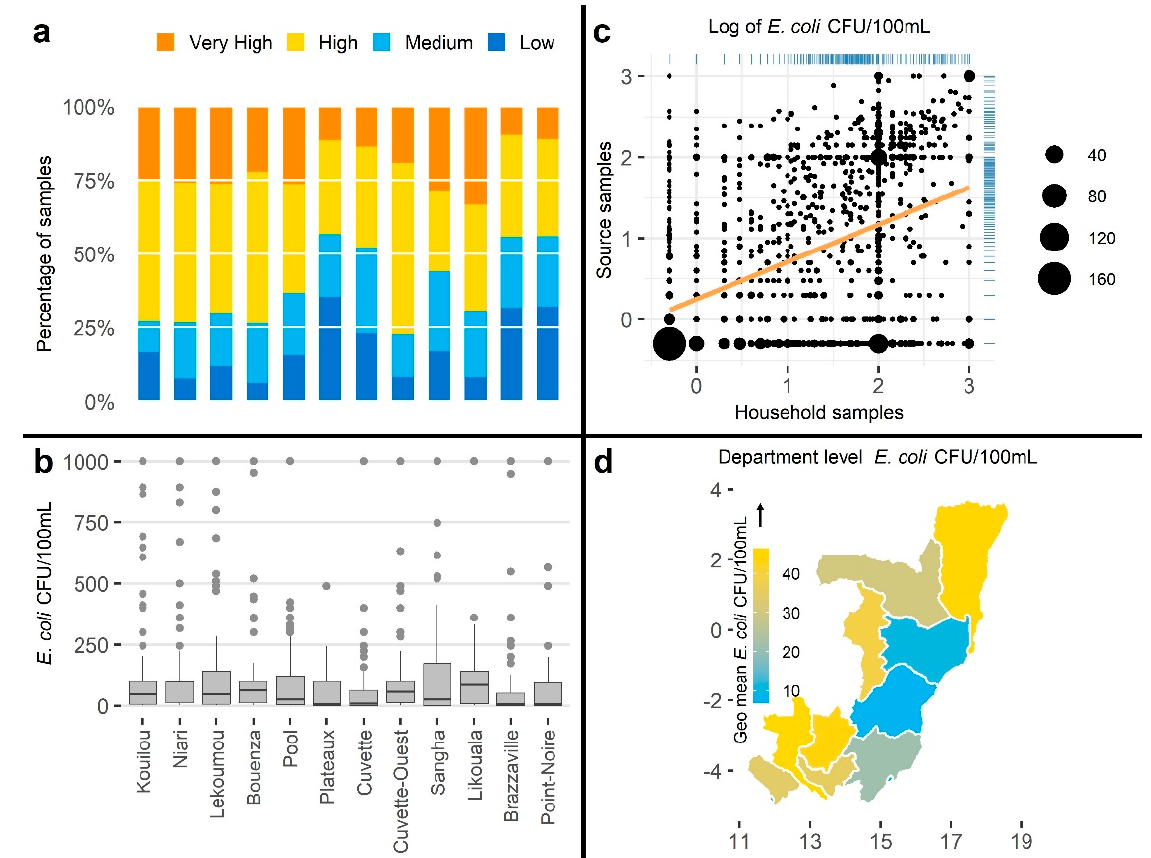
Figure 5. Examples of different visualization for Congo data: ( a ) bar plot of WHO risk categories in household water samples by administrative units, ( b ) box plot of E. coli CFU/100 mL in household water samples by administrative units, ( c ) scatter plot of log-transformed E. coli CFU/100 mL in household and corresponding source water samples, and ( d ) map of geometric mean of E. coli CFU/100 mL in household water samples by administrative units.